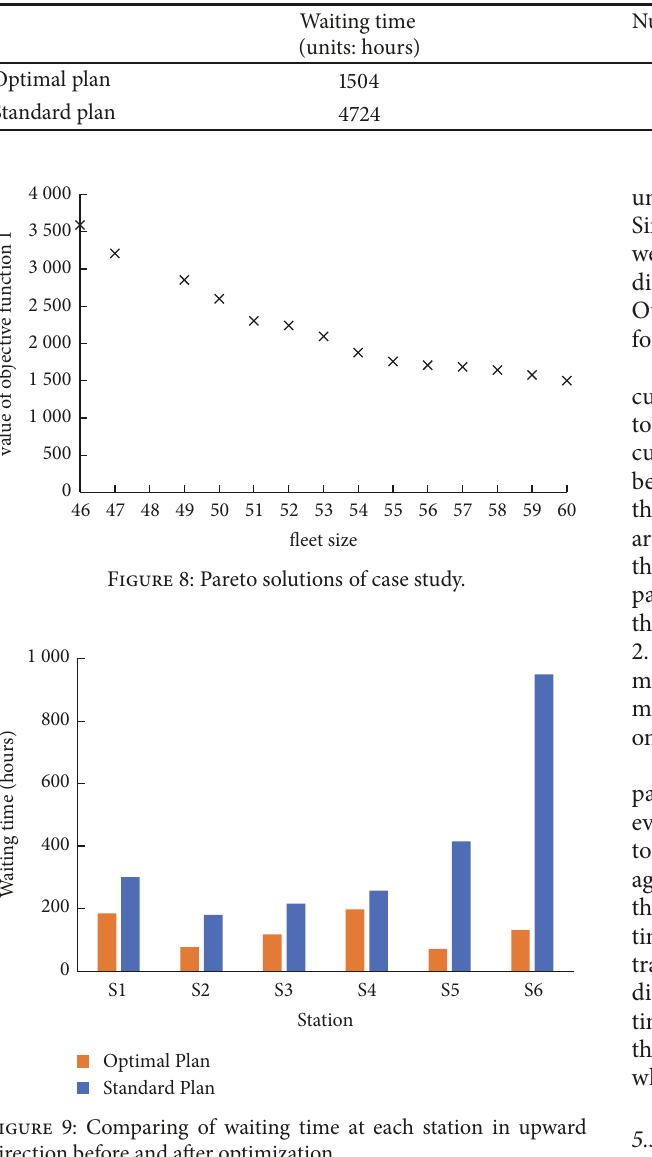
Table 5: Comparing of optimization results before and after optimization.